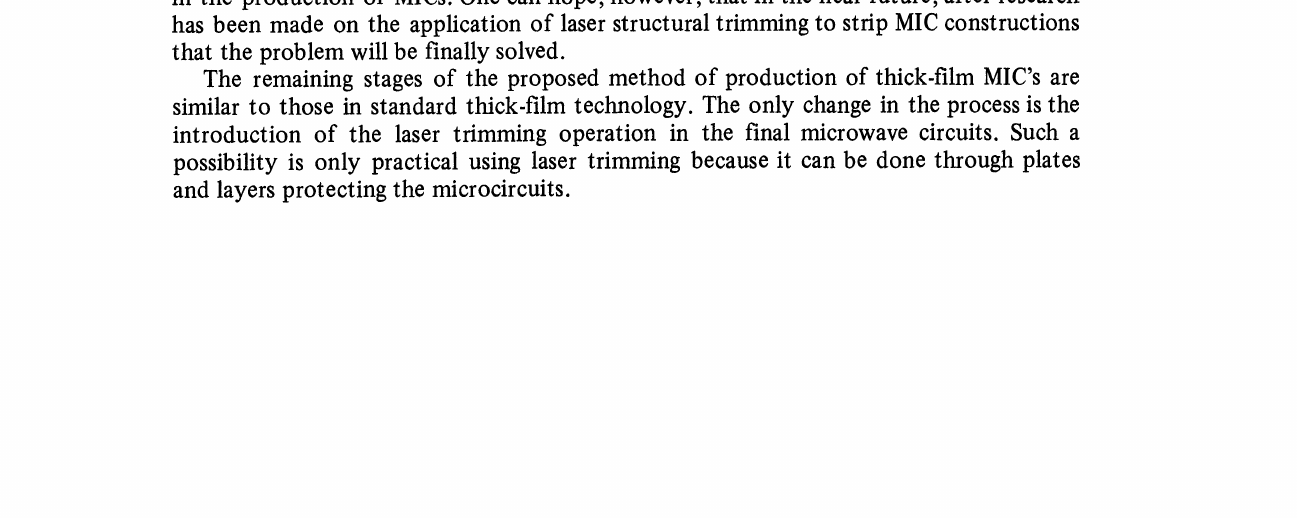
FIGURE 21 Q-factor as a function of firing temperature. Pastes" DP9770 and DP9791. Substrate: alumina ceramics (96% A120, Z 50S2). 1. Theoretical curve calculated according to Puce112 for DP9922 paste. (Du Pont; Cu paste). 2. Theoretical curve calculated according to PuceP for DP9770 paste. 3. Theoretical curve calculated according to Schneider for DP9770 paste. 4. Empirical curve for average value of a, for DP9770 and DP9791 pastes. 5. Theoretical curve calculated accordingly to homogeneous density of current model, for DP9770